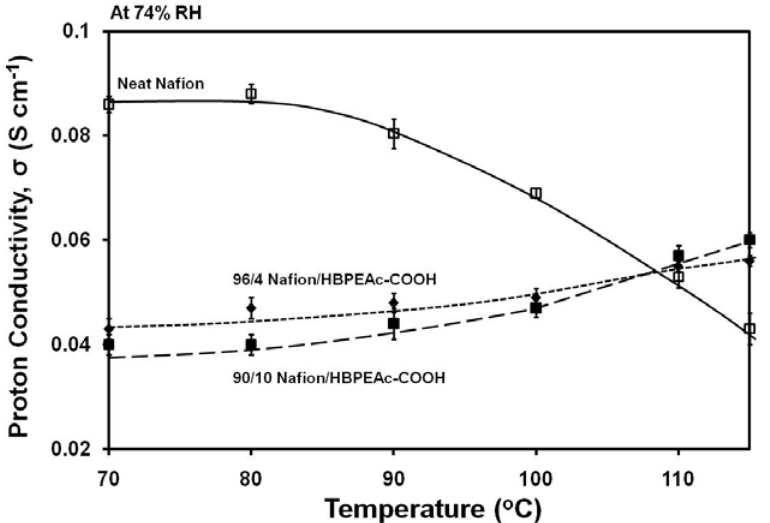
Figure 12. Proton conductivity plots of neat Nafion and impregnated membrane as a function of temperature at 74% RH. Proton conductivity of neat Nafion plummets beyond 80 °C while the conductivity value of the impregnated membrane continues to increase with temperature. Notice that the proton conductivity of the impregnated membranes is improved for about 30% over that of neat Nafion at 115